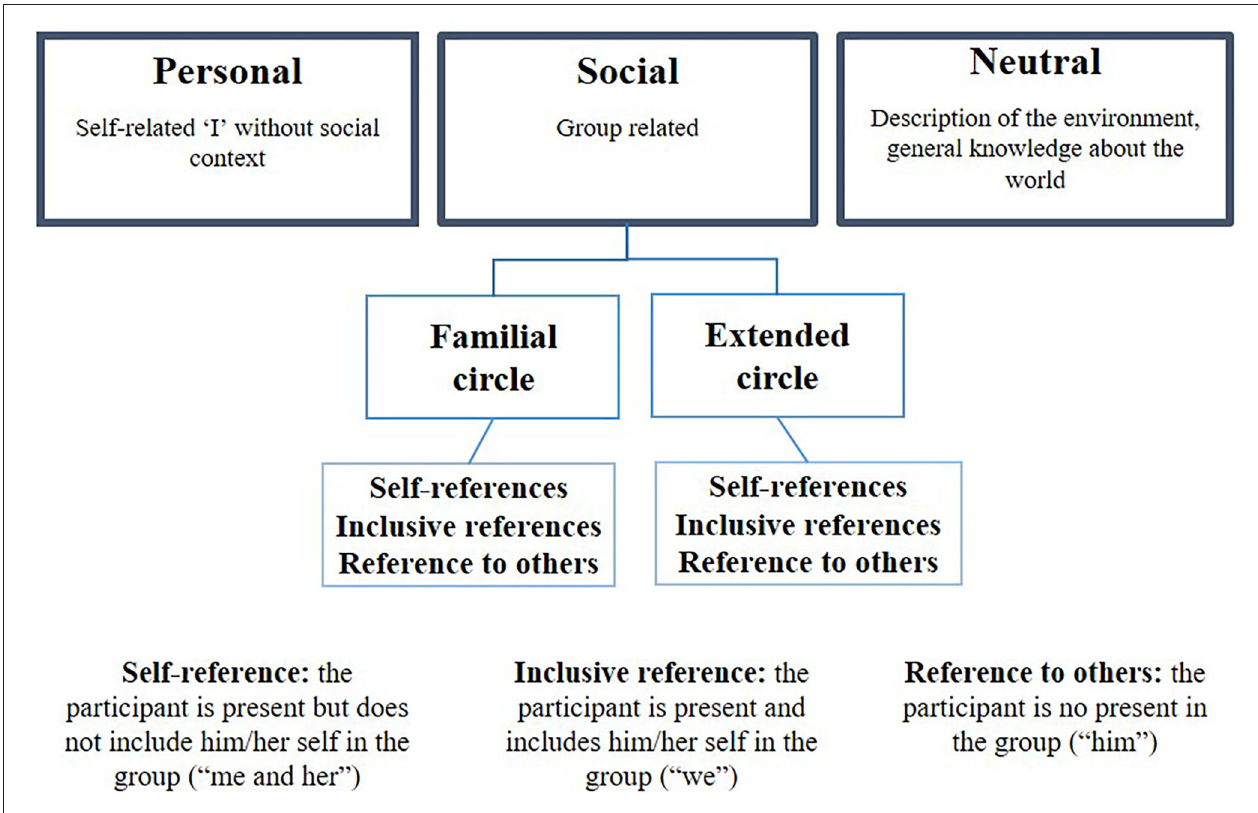
FIGURE 1 | Autobiographical memory